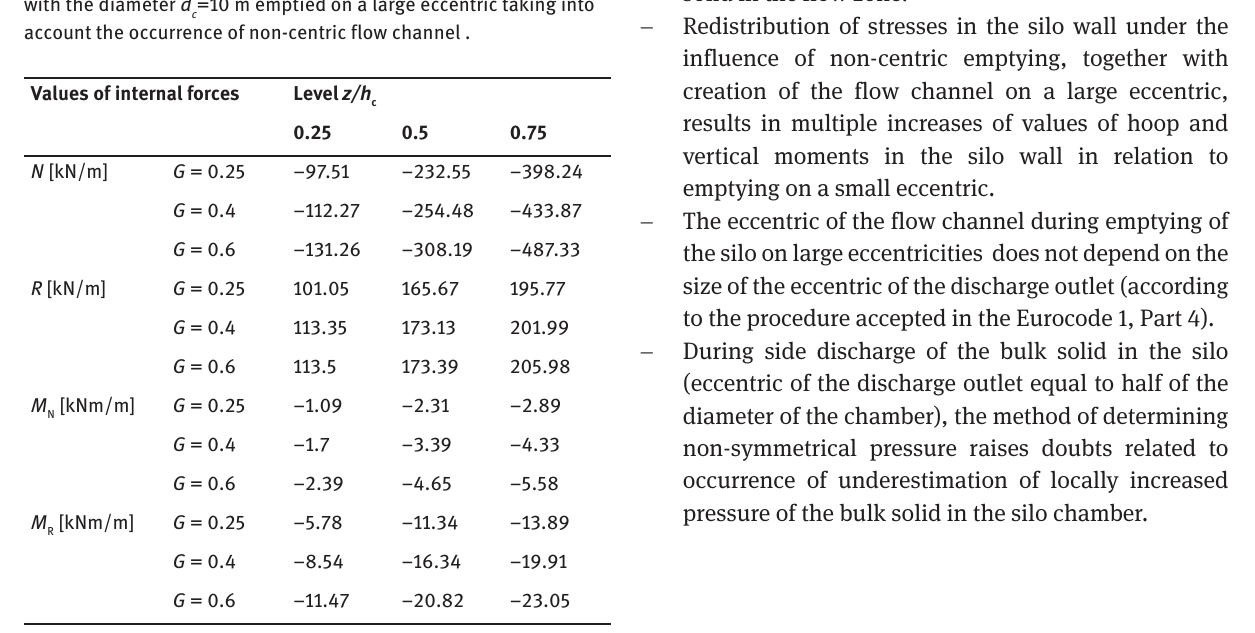
Table 7: Percentage comparison of values of hoop moments in the silo with the diameter d occurrence of flow channel with values calculated on the eccentricity limit e